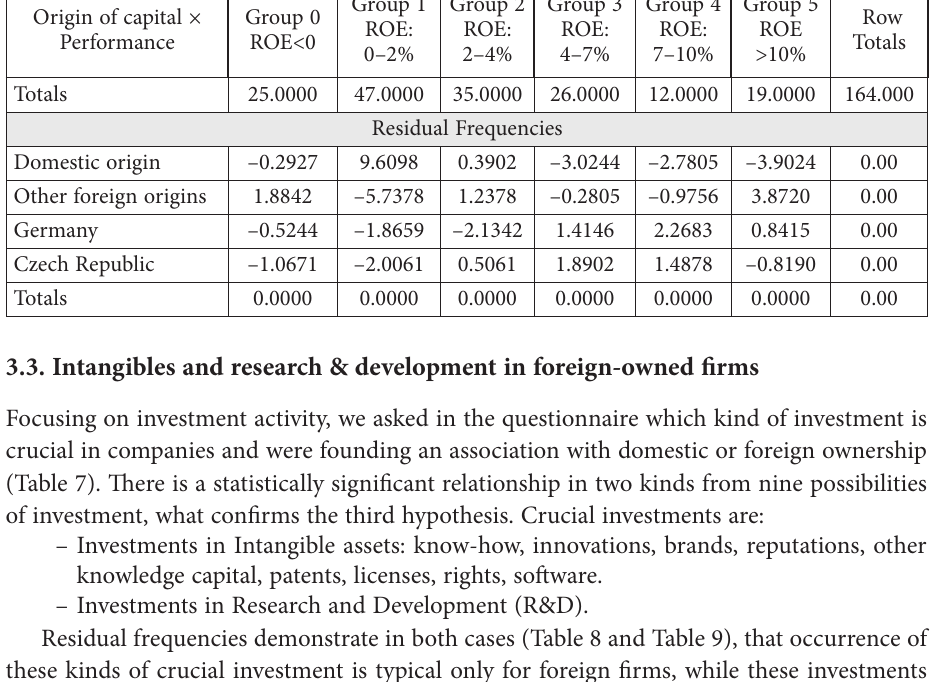
Table 7. Contingency: foreign ownership × crucial investment – statistics (source: own) Foreign ownership × Crucial investment (Statistic)